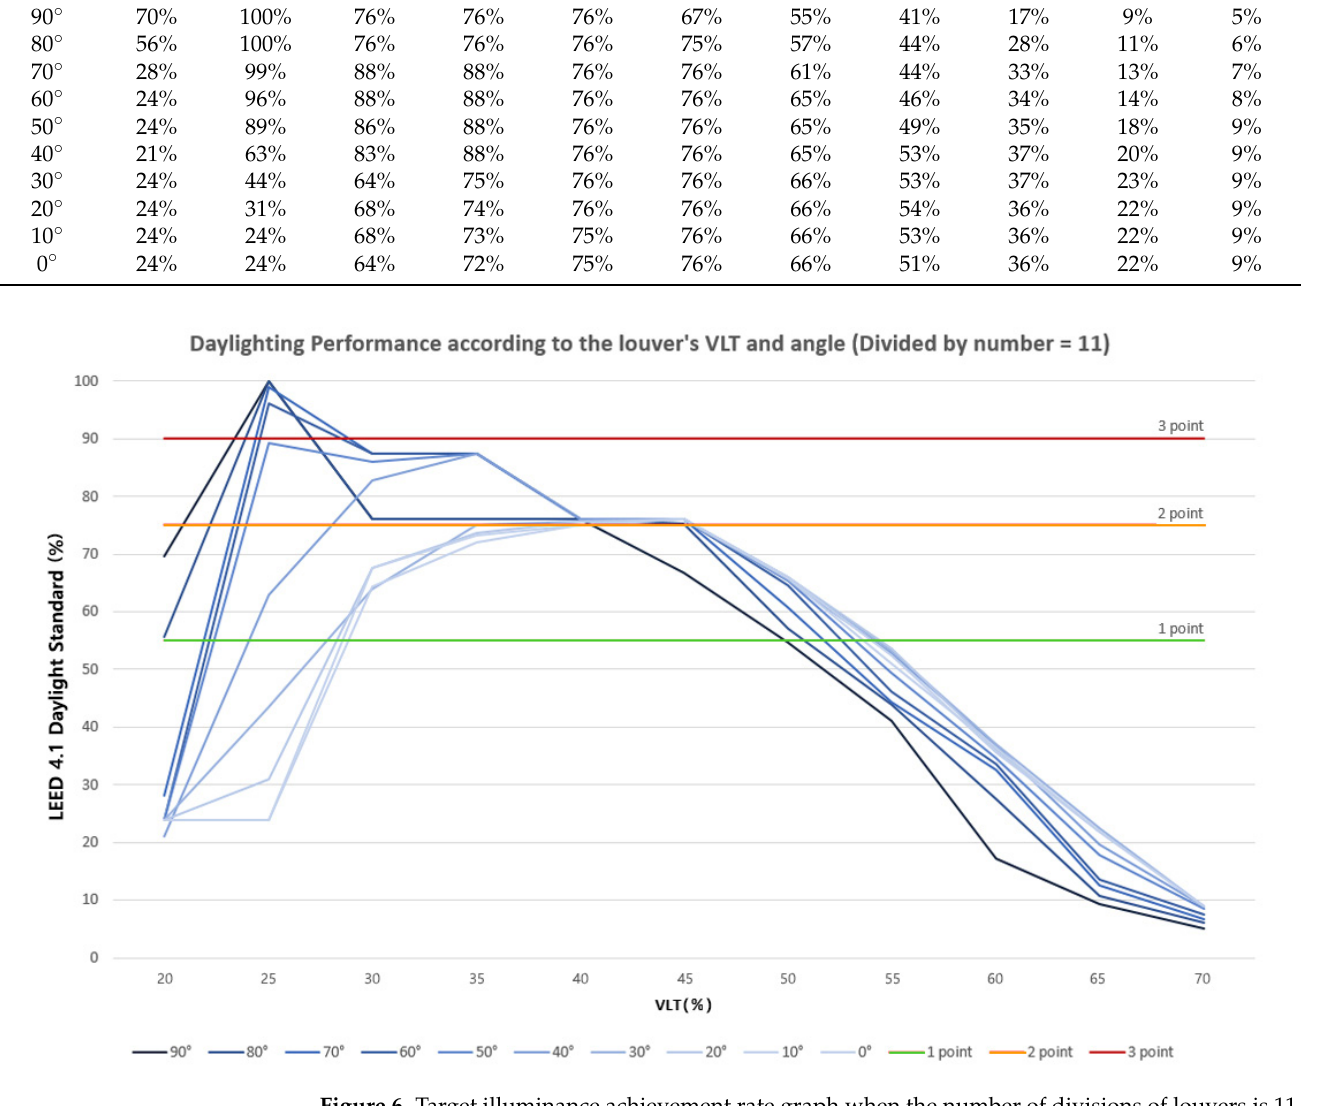
Table 6. Target illuminance achievement rates when the number of divisions of louvers is 12.